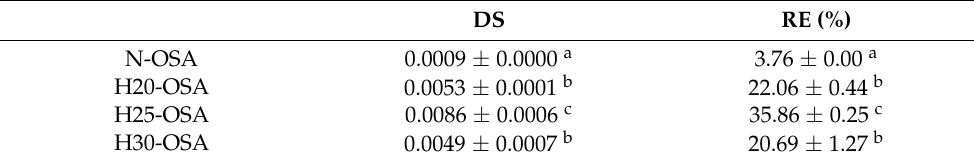
Table 3. Degree of substitution and reaction efficiency of native-OSA and HMT-OSA starches †